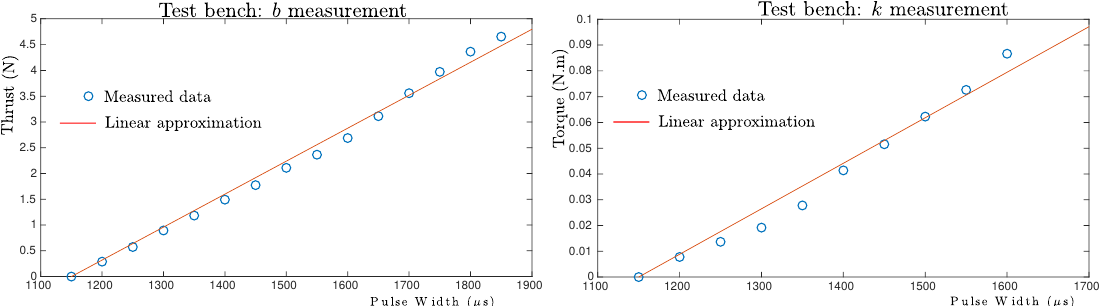
Figure 10. Linear approximation models obtained for the thrust coefficient b and the drag coefficient k using a custom-built test